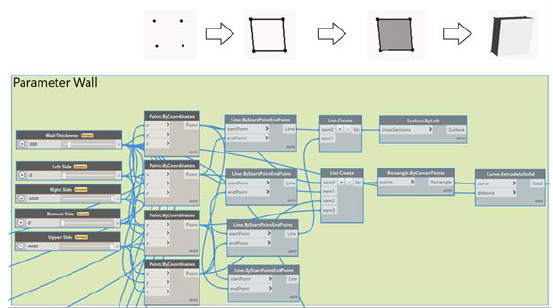
Figure 5. Detailed illustration of the Parameter Wall nodes group.